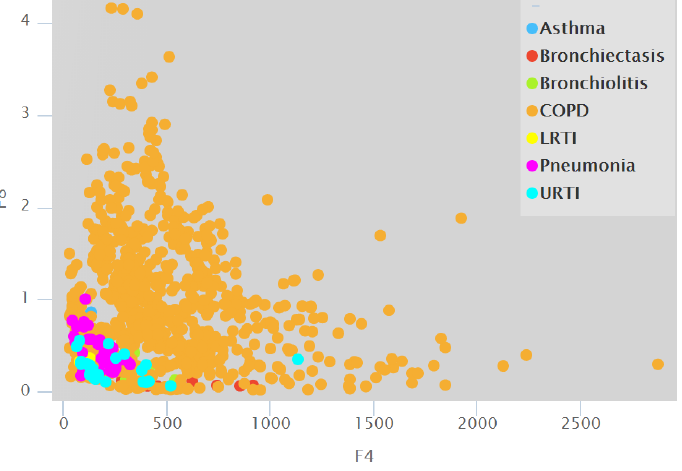
Figure 4. Scatterplot for the F 8 (i.e., Zero Crossing Rate) and F 4 (i.e., Bandwidth) features.